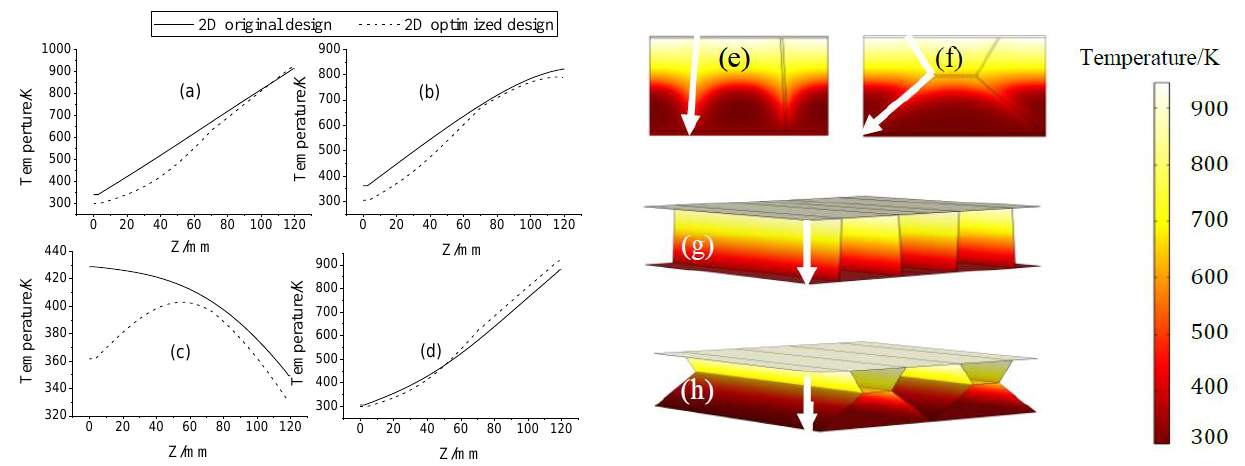
Figure 5. Temperature along the thickness direction at ( a ) Time 1, ( b ) Time 2, ( c ) Time 3 and ( d ) Time 4. Temperature contours in ( e ) 2D original design, ( f ) 2D optimized design, ( g ) 3D original design and ( h ) 3D OPT1. The paths are marked by arrows.